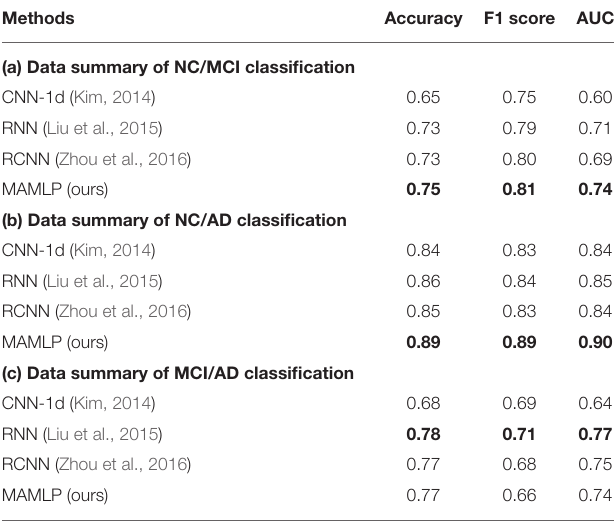
TABLE 6 | Data summary of different models in binary classification.